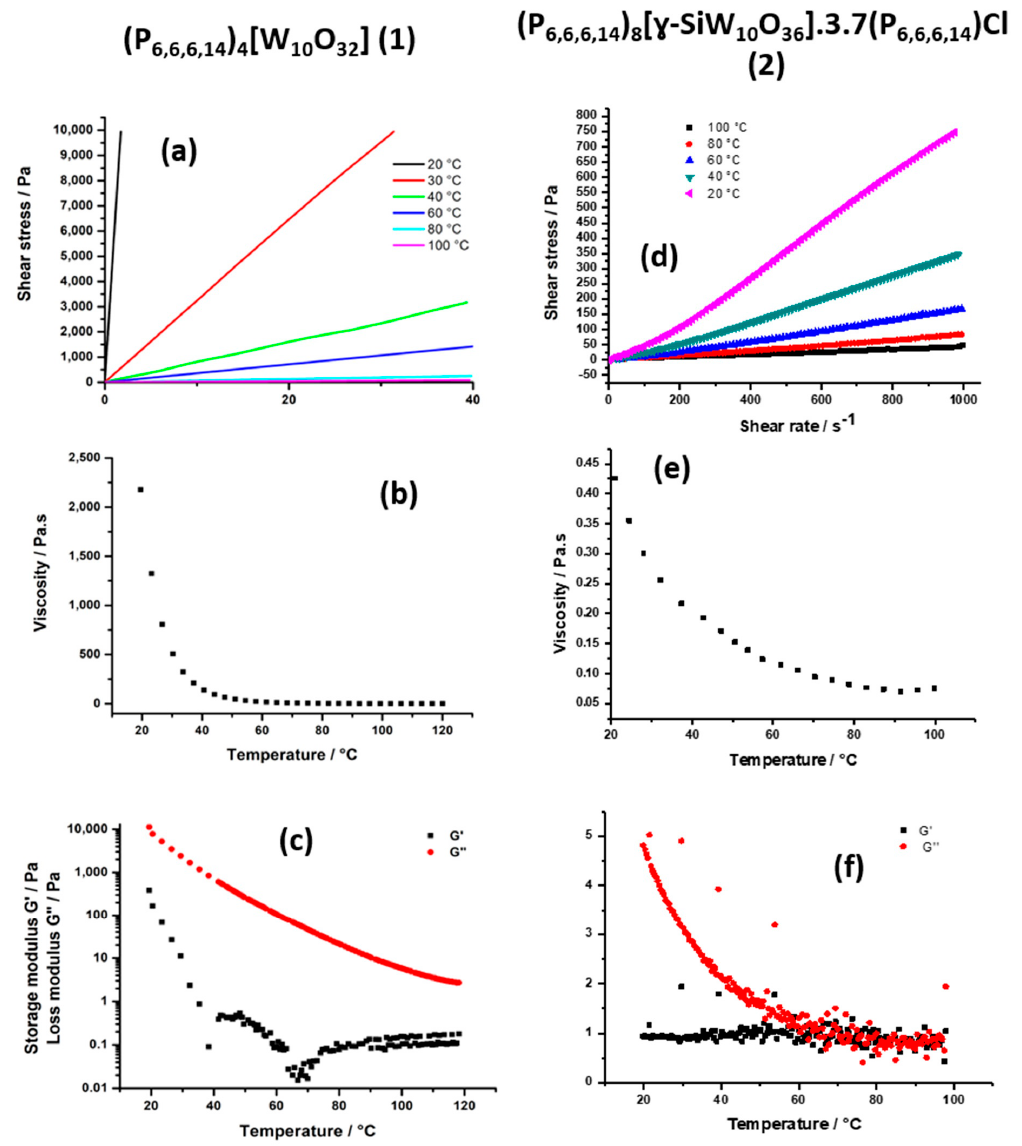
. Figure 5. Flow curves τ = f( 𝛾(cid:4662) ) measured between 20 and 100 °C for 1 ( a ) and for 2 ( d ); Viscosity variation as a function of Figure 5. Flow curves τ = f( γ ) measured between 20 and 100 ◦ C for 1 ( a ) and for 2 ( d ); Viscosity variation as a function of . the temperature between 20 °C and 100 °C (cid:4666)𝛾(cid:4662) = 10 s − 1 ) for 1 ( b ) and 2 ( e ); Temperature dependence of G’ (black dots) and γ = 10 s − 1 ) for 1 ( b ) and 2 ( e ); Temperature dependence of G (cid:48) (black dots) and the temperature between 20 ◦ C and 100 ◦ C ( G’’ (red dots) with 20% strain and f = 1Hz for 1 ( c ), and 2 ( f ). G” (red dots) with 20% strain and f = 1 Hz for 1 ( c ), and 2 ( f